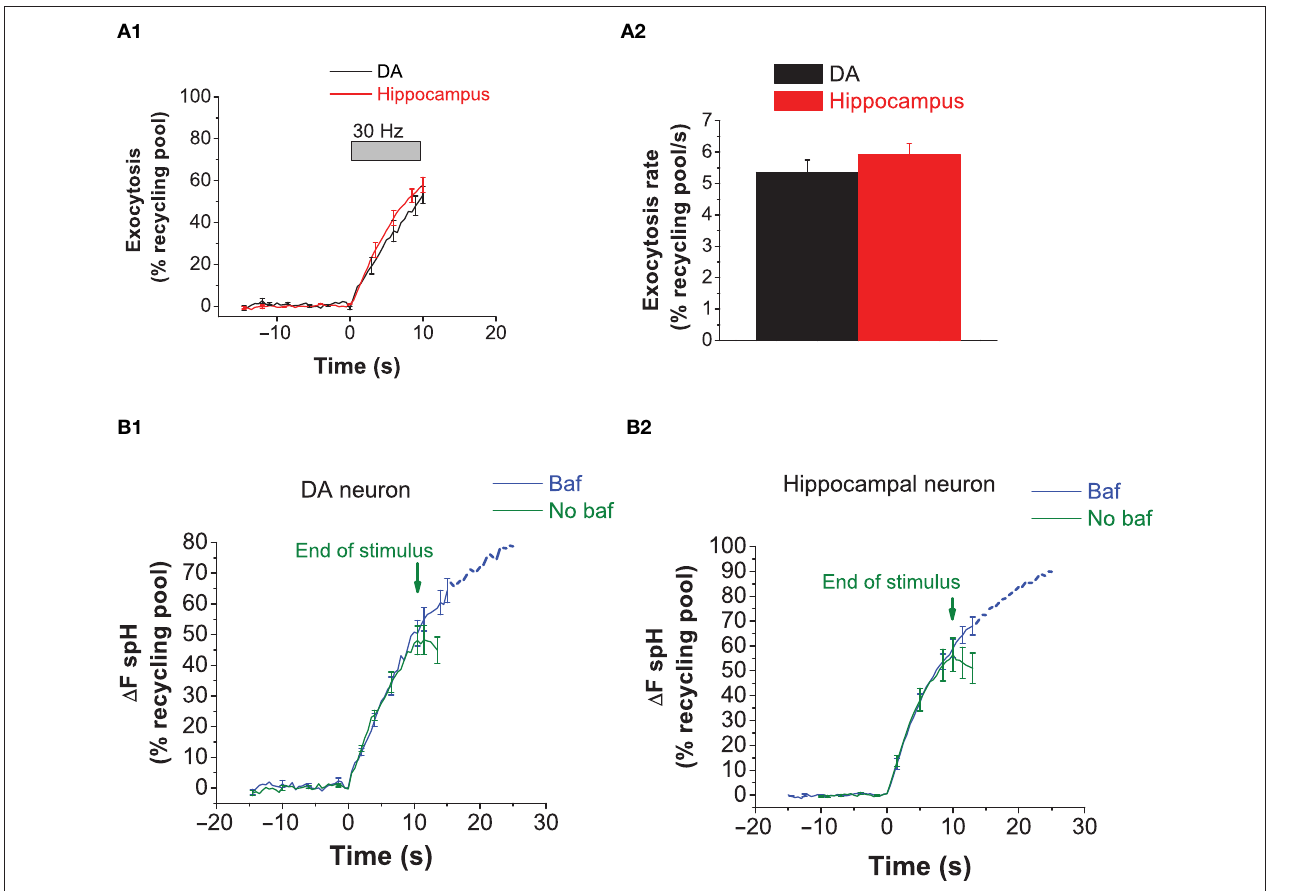
FIGURE 4 | The rate of exocytosis with a 30 Hz stimulus is similar in DA and hippocampal neurons. (A1) Average exocytosis at 30 Hz in DA (black) and hippocampal (red) neurons. The increase in fl uorescence with 30 Hz activity was measured in the presence of bafi lomycin. There is close overlap between the exocytosis traces in DA and hippocampal neurons during activity at 30 Hz. Data averaged from six DA and eight hippocampal neurons. Each experiment consists of 10–50 presynaptic terminals from one neuron. Error bars are SEM. (A2) The rate of exocytosis at 30 Hz [slope from linear fi tting of traces from (A1) ] is similar between DA (black bar) and hippocampal (red bar) neurons. (B1) The average